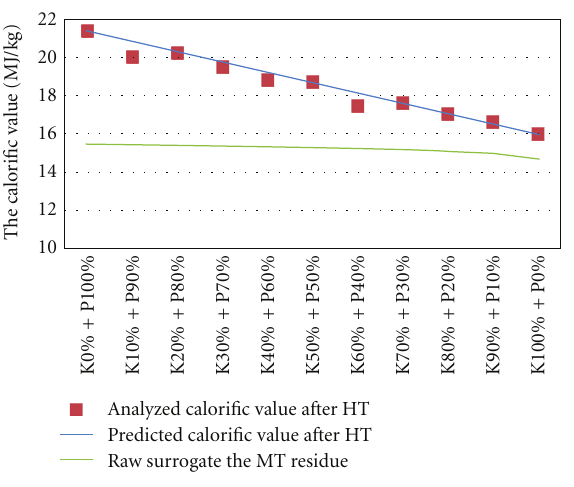
Figure 7: Change of the calorific value of the hydrothermal products by changing the mixture ratio of the paper andkimchi (hydrothermal reaction temperature (cid:2) 200 ◦ C).